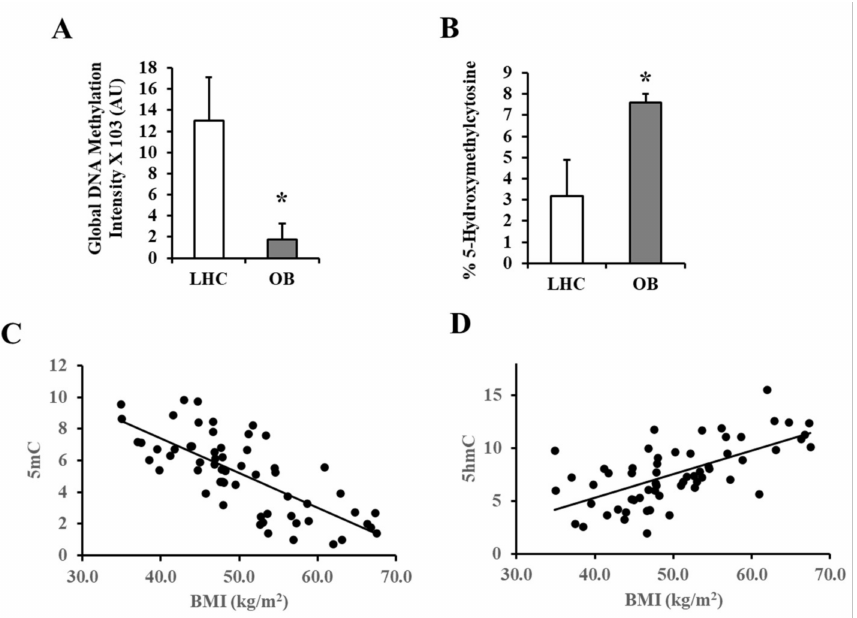
Figure 2. Global methylation and hydroxymethylation in VAT-derived DNA. ( A , B ) Representative charts for the quantification of 5-mC and 5-hmC in VAT-derived DNA samples obtained from obese and non-obese subjects ( n = 60, each). ( C , D ) Scatter plots and Spearman correlation coefficient (r) of 5-mC and 5-hmC measurements and BMI. Results are shown as means ± standard error (SE), and the * symbol reflects a p -value < 0.05 when comparing obese subjects with controls.